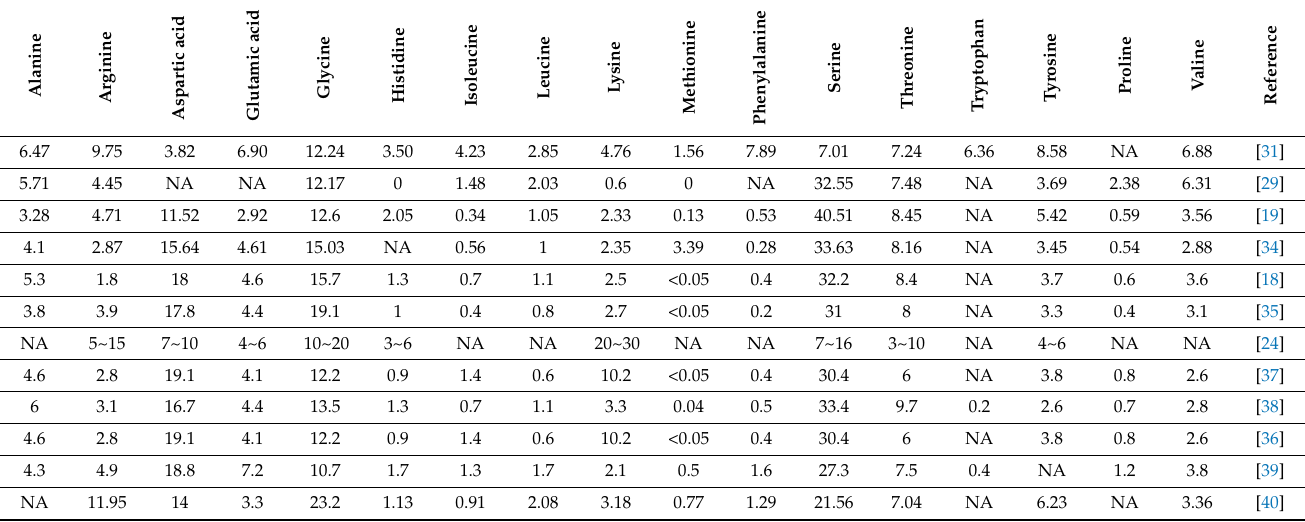
Table 2. The amino acid profile of sericin as per different works published in the